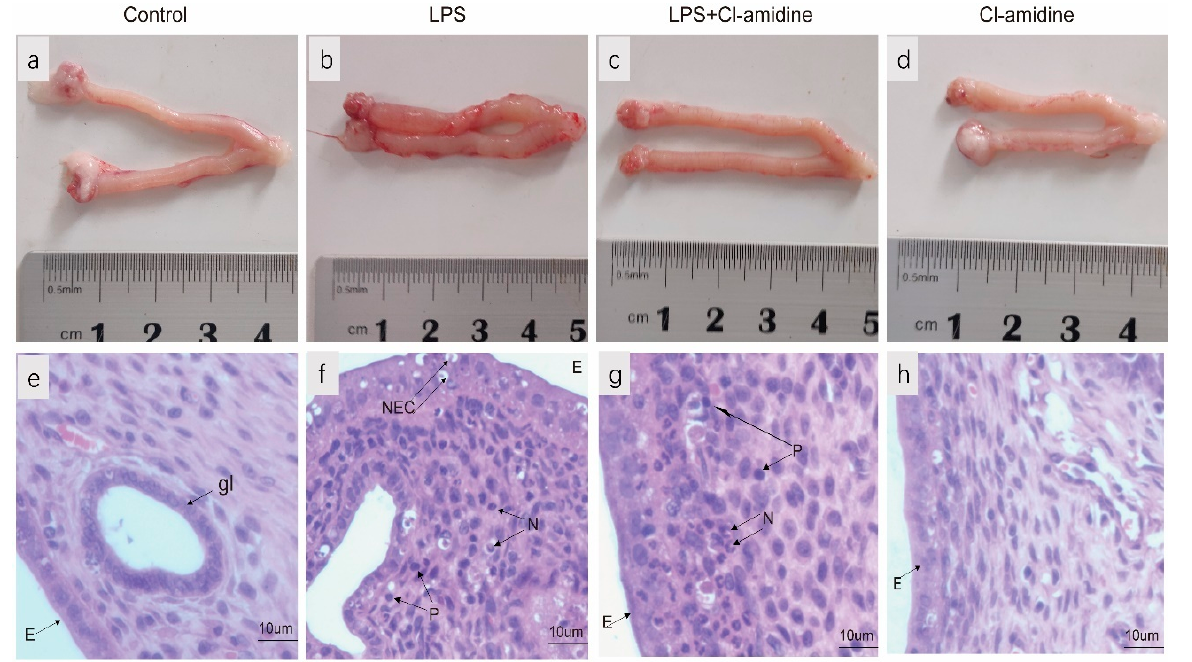
Figure 1. Anatomical changes and characterized pathological change in uterus inflammation. Anatomical changes in ( a ) control, ( b ) LPS treated group, ( c ) LPS + Cl-amidine treated group, and ( d ) Cl-amidine treated group. Characterization of pathological sections of ( e ) control, ( f ) LPS, ( g ) LPS + Cl-amidine, and ( h ) Cl-amidine. Cells labeled as N, neutrophil; NEC, necrosis epithelial cell; P, plasmacyte. The letter E indicates Epithelial Cells, whereas the letter gl indicates gland. Magnification 400 × .